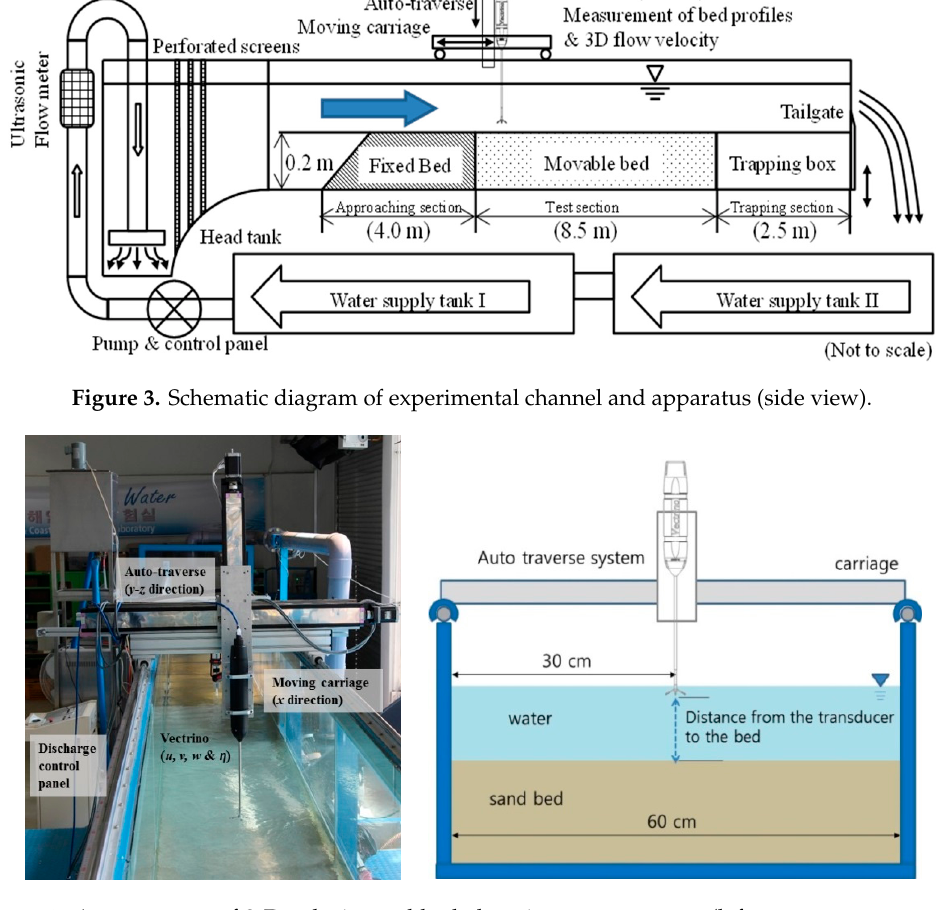
Figure 4. Arrangement of 3-D velocity and bed elevation measurement (left: sensor arrangement; right: schematic diagram).